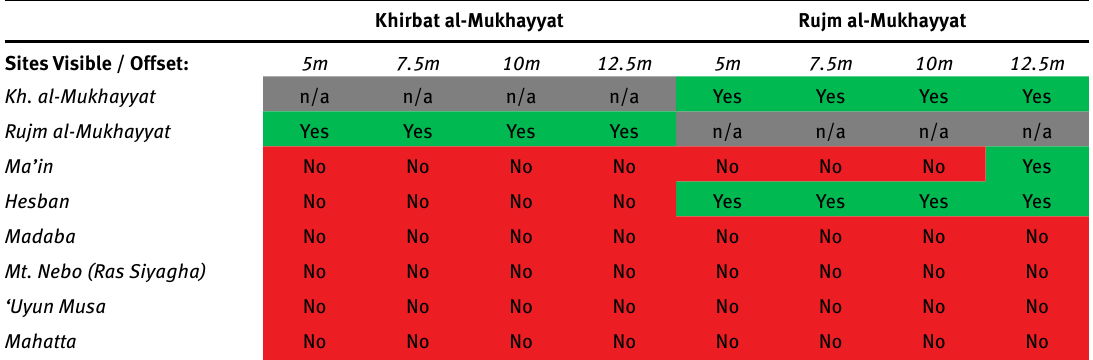
Table 1: Sites visible from Khirbat al-Mukhayyat and Rujm al-Mukhayyat at 5 m, 7.5 m, 10 m and 12.5 m observer/target offsets.